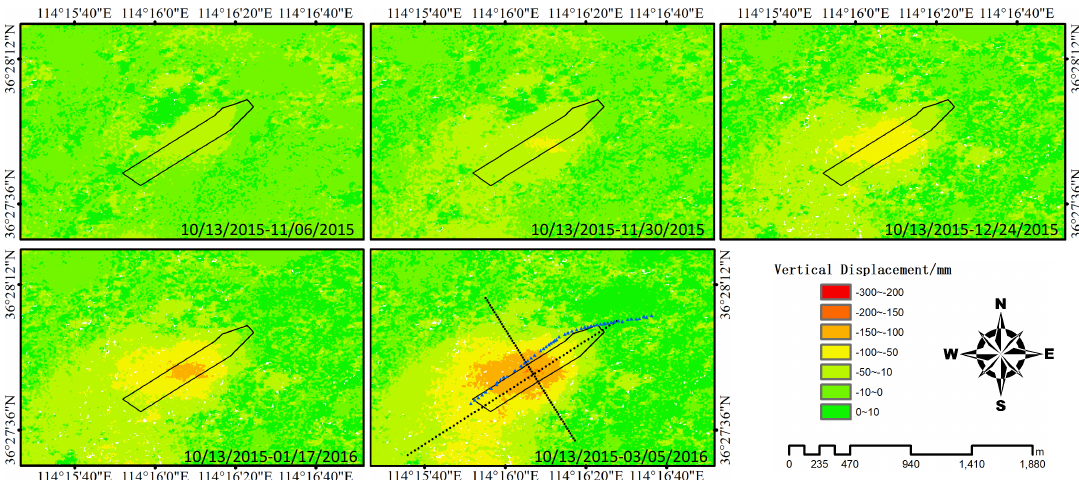
Figure 10. Time series surface subsidence. The black box represents the shape and location of the working face. The blue and black points in the last graph are the location of the leveling points and sampling points,